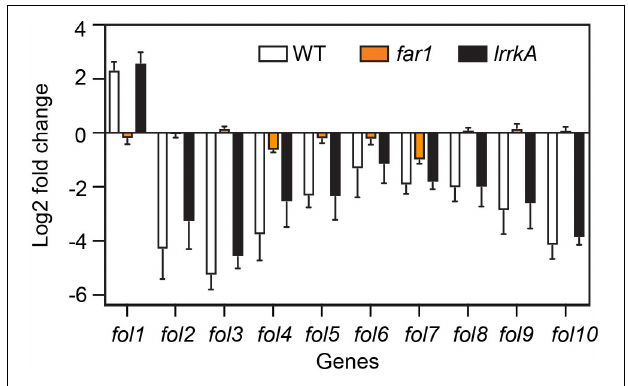
FIGURE 7 | Folate control of gene transcription is independent of LrrkA. We measured by qPCR the levels of various RNAs in cells exposed or not to folate. The average and SEM of three independent experiments are shown. As previously observed, the transcription of genes fol1 - fol10 is altered when cells are exposed to folate (increased for fol1 , decreased for fol2-10 ). This regulation is essentially lost in far1 KO cells. On the contrary, in lrrkA KO cells, transcriptional response to folate is indistinguishable from that observed in WT cells.